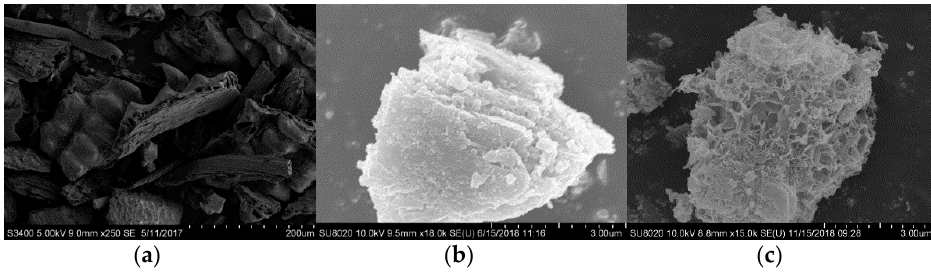
Figure 6. Scanning electron microscope of rice husk ash, carbide slag and modified absorbent: ( a ) rice hush ask, ( b ) carbide slag and ( c ) modified absorbent.